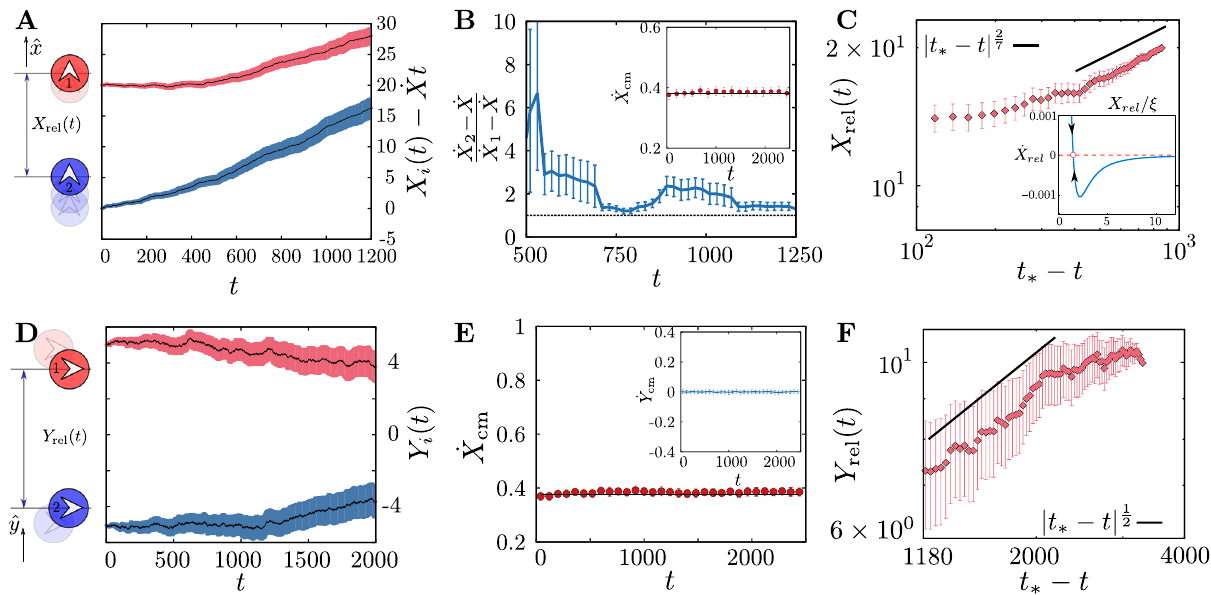
Fig. 7 | Dynamics of two particles moving through the passive medium. A – C . Two active particles moving along the x -axis (the direction of their active forces whose magnitude f =2, and large persistence time τ ) with separation vectors par- allel to the direction of motion. A Time dependence of the positions of the pair of active particles (after subtracting the measured single particle displacement _ Xt ), along ^ x . B Theratioofthe particle velocitiesremainsgreaterthanone,indicating a speed up of the trailing particle towards the leading particle, a manifestation of nonreciprocity . Inset: the centre of mass velocity _ X cm ð t Þ remains positive and con- stant(solidline is the predictionfromtheory). C The two active particles approach each other in fi nite time t * . The solid line, a prediction from theory, suggests a scalingform X rel ∝ ∣ t − t * ∣ α ,where α =2/7.Asthesecondparticleapproachesthe fi rst, it forms a bound state with the fi rst particle, characterised by the existence of a